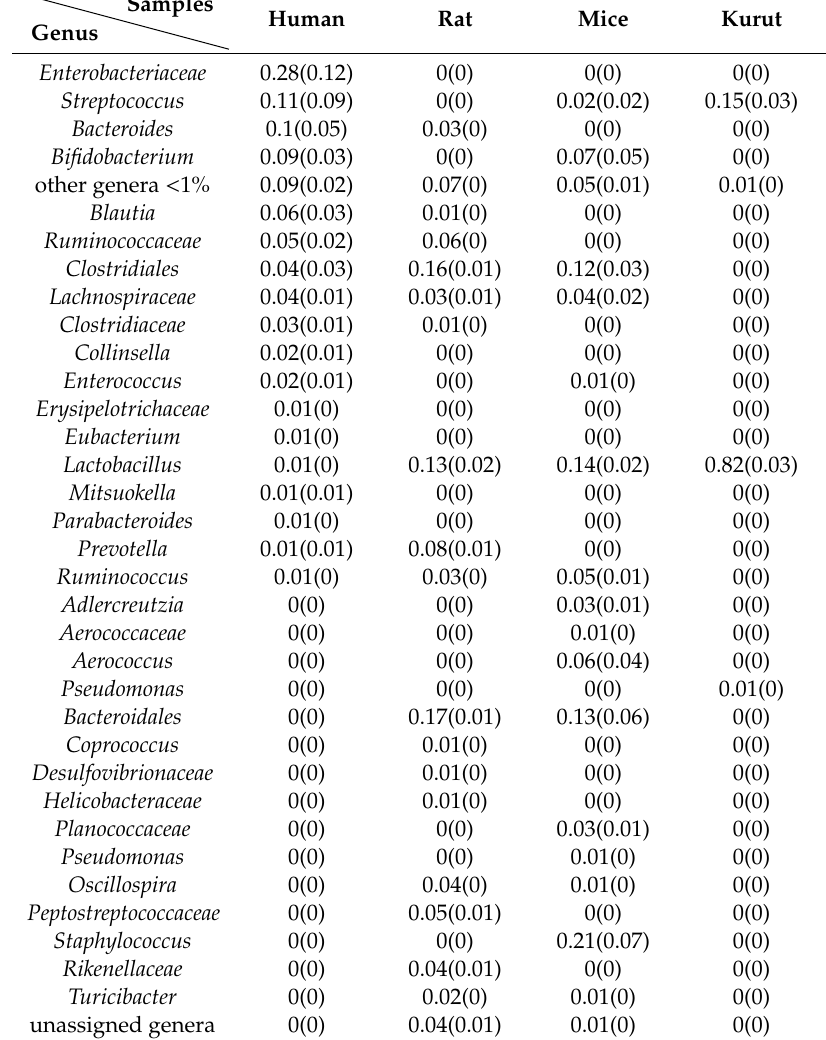
Table 1. 16S rRNA profiling method of the microflora composition of four di ff erent habitats 1